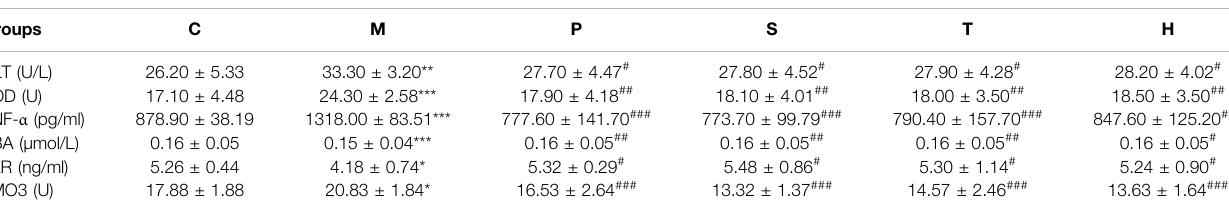
TABLE 2 | Effect of three phenylethanoids on hepatic metabolic parameters in mice. Groups